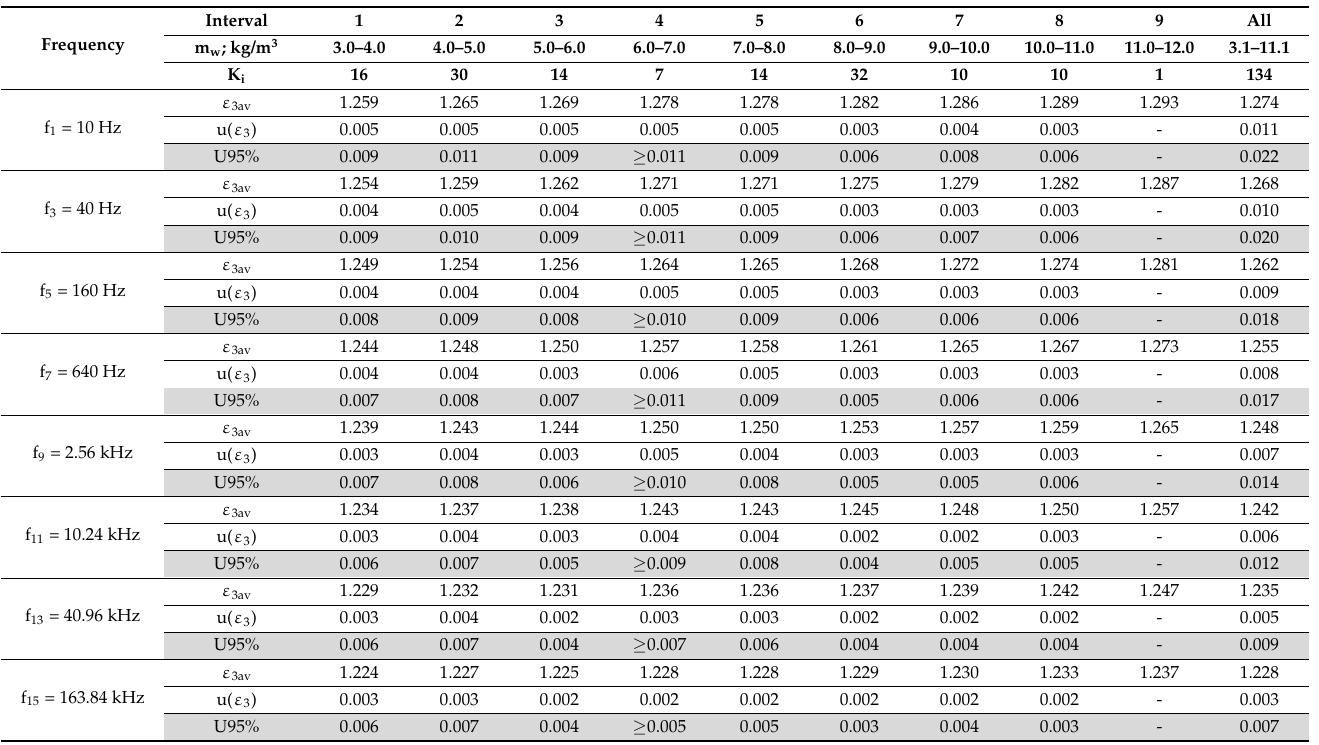
Table 3. Measurement uncertainties of permittivity of PU SikaBlock ® -M150 foams (density of 144 kg/m 3 ) (short series).